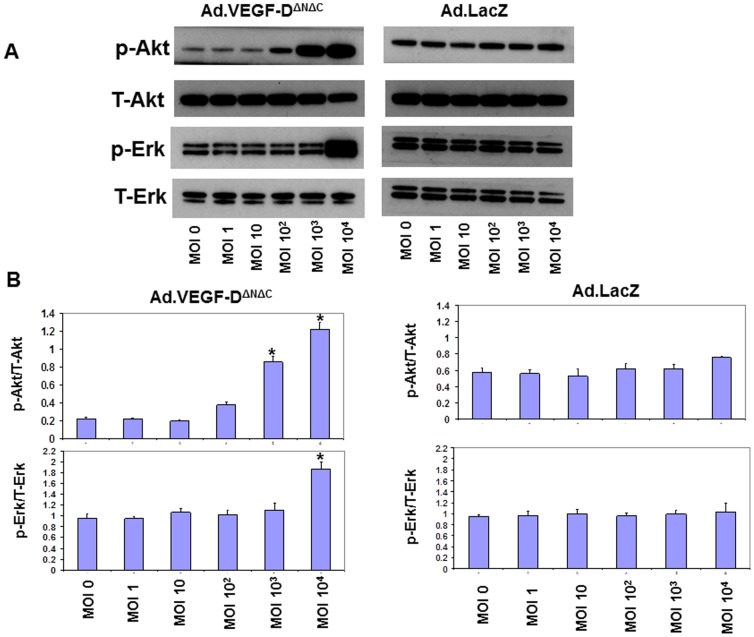
Representative western blots showing an upregulation in p-Akt and p-Erk levels 48 hours after Ad.VEGF-DΔNΔC infection in pregnant sheep UAECs.Pregnant sheep UAECs were grown in culture for up to 4 passages, and then infected at increasing MOIs with Ad.VEGF-DΔNΔC or Ad.LacZ in 6-well plates. Protein was extracted from infected cells 48 hours later, and assayed for p-Akt, T-Akt, p-Erk and T-Erk levels by western blotting. (A) An increase in p-Akt and p-Erk levels with increasing MOI was observed in Ad.VEGF-DΔNΔC infected cells, but not Ad.LacZ infected cells. (B) Densitometric analysis was performed on the p-Akt and p-Erk bands using Image J software, after normalizing against the density of T-Akt and T-Erk bands respectively. Results are representative of n = 3 independent experiments. * indicates p<0.05 in comparison to the relative density of the corresponding band from uninfected cells (MOI = 0) by t-test.